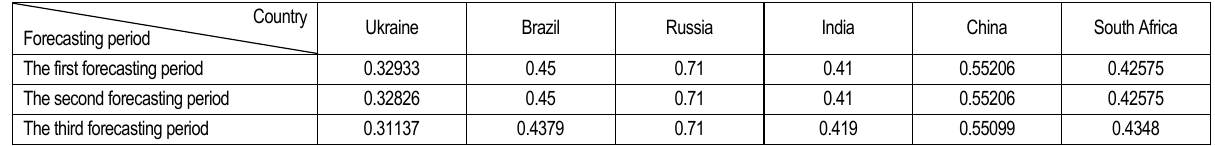
Table 11. Forecasting meanings of integral index for Ukraine and BRICS member countries in three year perspective